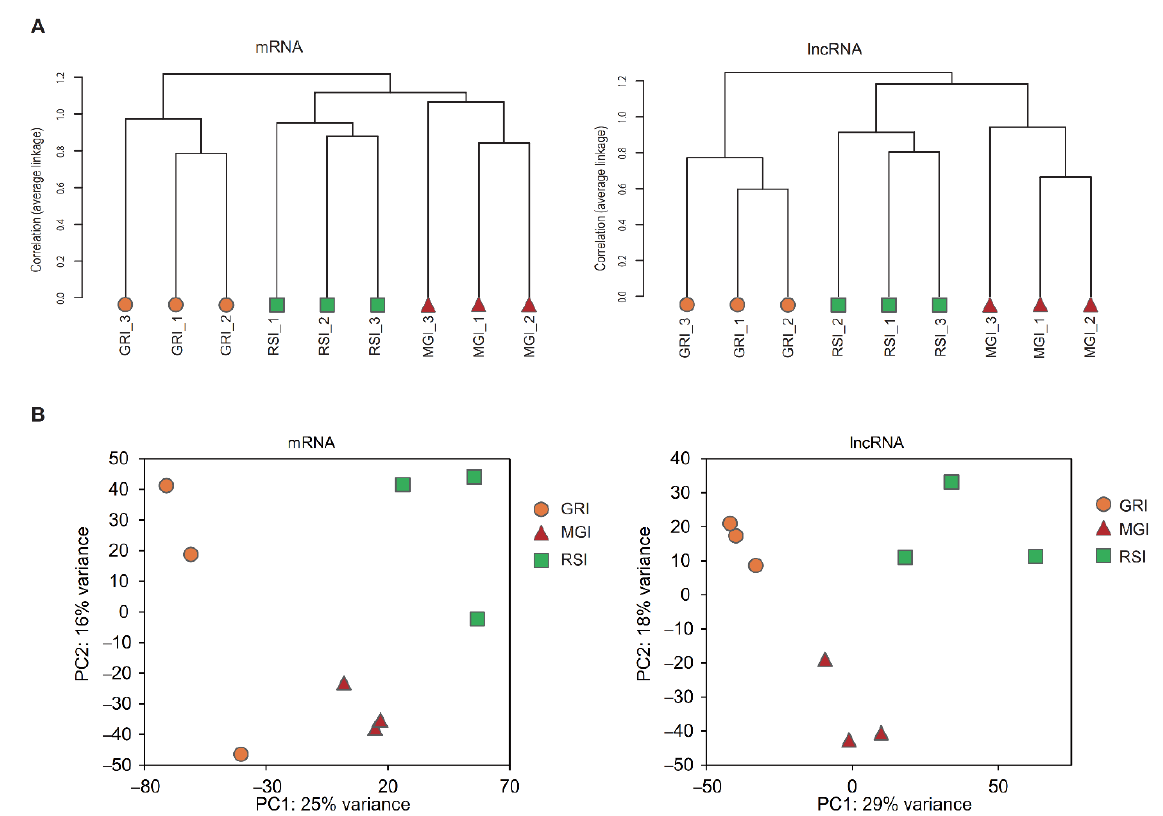
Figure 2. Hierarchical clustering of sample tree ( A ) and PCAs ( B ) of all expressed mRNAs and lncRNAs in different development stages of muscle. Abbreviations: MGI, the inflection point with the maximum growth rate; GRI, the inflection point of the gradually increasing stage to the rapidly increasing stage; RSI, the inflection point of the rapidly increasing stage to the slowly increasing stage.